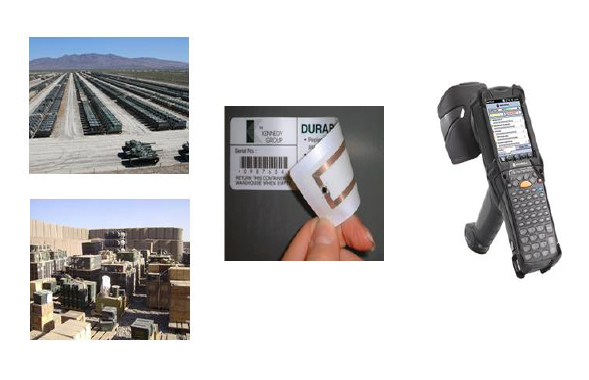
Figure 1. Connecting RFID tags to all military logistics (supplies) in all garrisons in order to control incoming and outgoing logistics via readers.